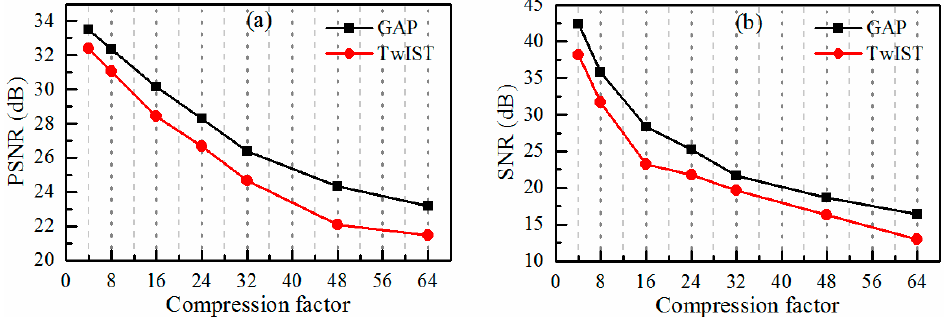
Figure 3. The simulation results for a sinusoidal audio signal with a frequency of 50 Hz. ( a ) The reconstruction quality of the light spot video images as a function of the compression rate for both the GAP (Generalized Alternating Projection) and TwIST (Two-step Iterative-Shrinkage Thresholding) algorithms; ( b ) the quality of the sound signal recovered by the reconstructed sound vibrating light spot video as a function of the compression rate.